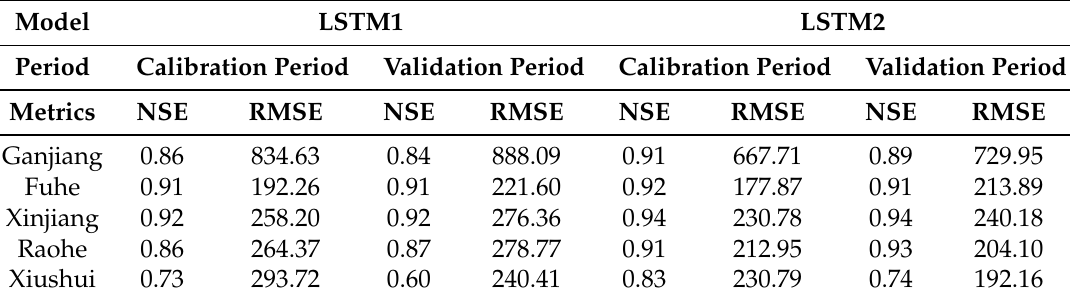
Figure 6. Model performance with different window size (( A ) root mean square error; ( B ) Nash-Sutcliffe Efficiency). Table 2. Performances of LSTMs in runoff